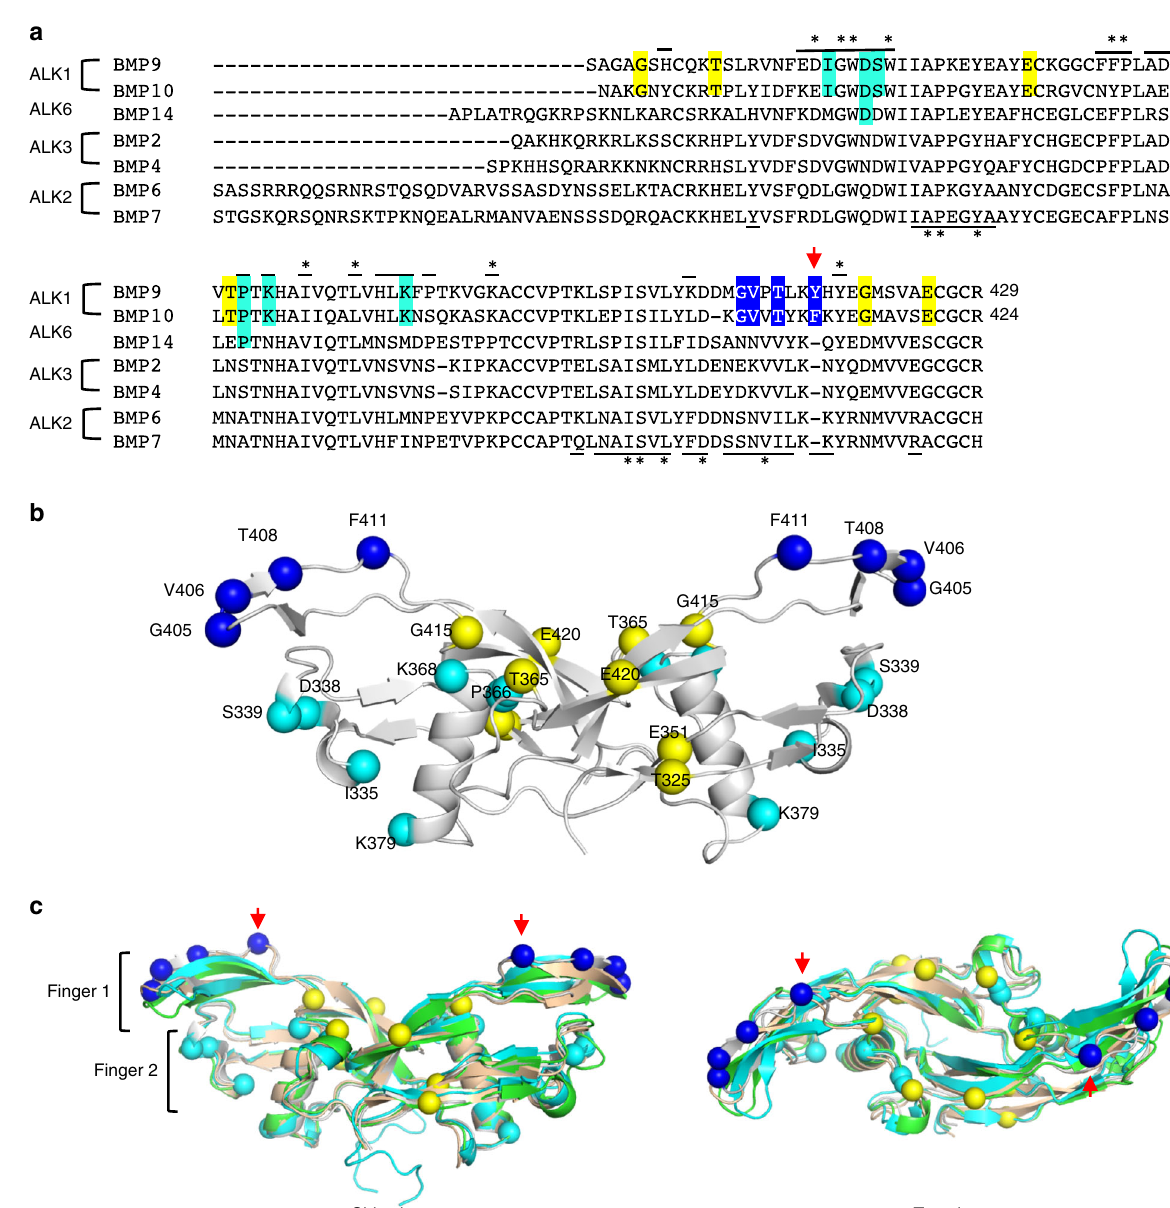
Fig. 3 Speci fi city determinants in the BMP9 and BMP10 subfamily. a Sequence alignment of representative ALK-binding BMPs. GF-domain sequences of ALK1-binding BMP9 and BMP10, ALK6-binding BMP14, ALK3-binding BMP2 and BMP4, as well as ALK2-binding BMP6 and BMP7 are aligned. Lines over and below the sequences highlight the residues at the type I and type II receptor-binding surface based on BMP10:ALK1 and BMP9:ALK1:ActRIIb structures, respectively. Asterisk (*) marks the residues that are conserved among at least 6 out of 7 aligned BMPs. Residues preferentially conserved between BMP9 and BMP10 are highlighted, in cyan for those at the type I site (conserved region 1), in blue for those at the type II site (conserved region 2) and in yellow for those outside receptor binding surface (conserved region 3). BMP10 D338 and P366 are also highlighted in cyan because they make conserved interactions with ALK1 in the crystal structure (Fig. 4). b Residues from conserved regions 1 – 3 plotted on BMP10 structure and labelled with full length proBMP10 residue numbers. Fifteen residues from conserved regions 1 – 3 are shown in spheres, coloured accordingly. The fi rst Gly from conserved region 3 is not modelled in the crystal structure, and hence not plotted. c An overlay of BMP10 (grey) onto the structures of BMP9 (gold, from 4FAO) 9 , BMP2 (green, from 2GOO) 31 and BMP7 (cyan, from 1M4U) 61 is shown from the side view (left) and the top view (right). The red arrows indicate the unique insertion in BMP9 and